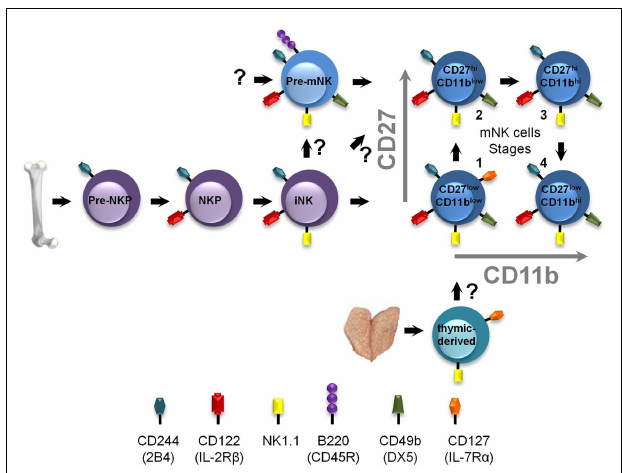
FIGURE 2 | Positioning pre-mNK cells in the NK-cell differentiation pathway . NK-cell differentiation is a multi-step process, wherein cellular intermediates can be distinguished based on the acquisition and loss of the expression of specific cell surface antigens, in mice. Pre-NKP cells represent the earliest defined mNK cell-committed progenitor. Here, pre-mNK cells are positioned as a cellular intermediate following iNK cells and preceding mNK cells. Question marks indicate differentiation steps that remain to be experimentally verified.The thymic-derived pathway is also